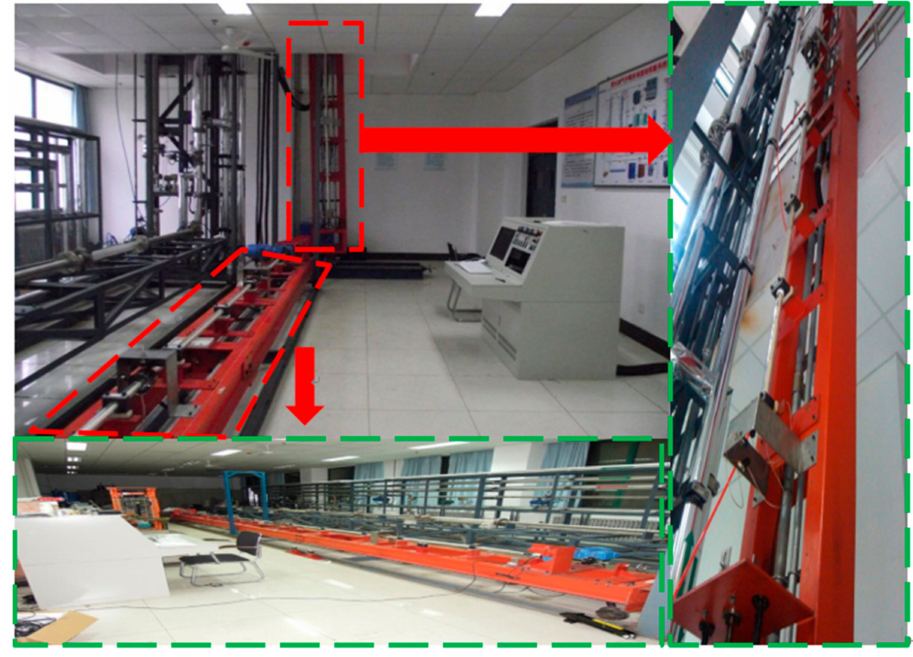
Figure 3. A photo of the experimental